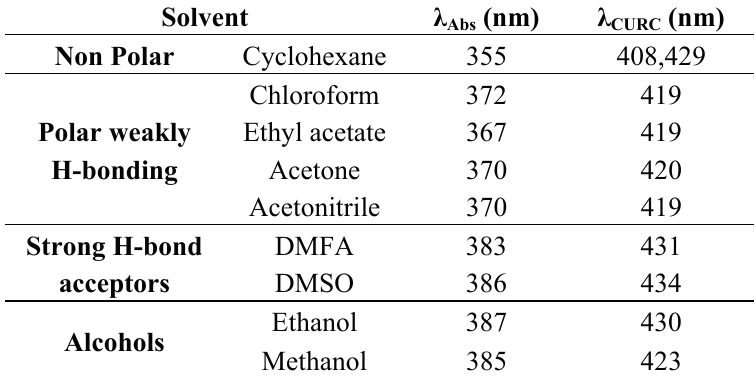
Table 2. Absorption maxima of the charge transfer band of CYV ( λ band of CURC ( λ ) in selected CURC